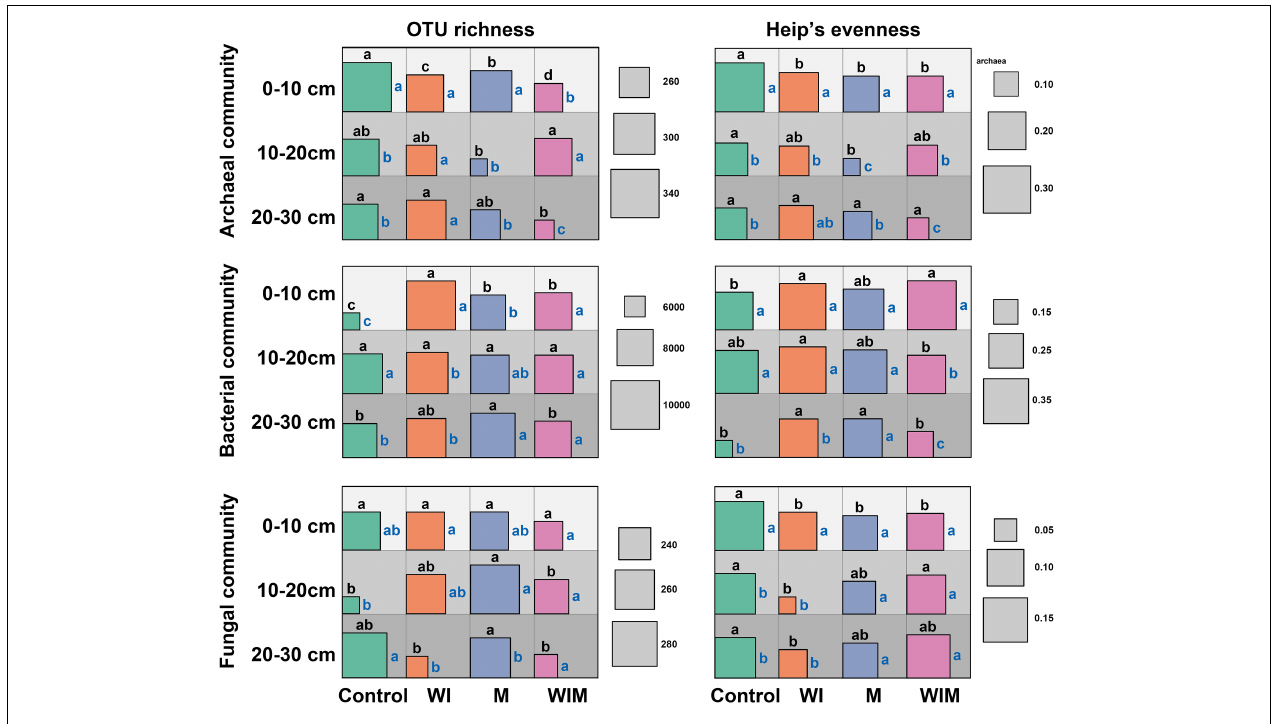
FIGURE 3 | Diversity (OTU richness and Heip’s evenness) of soil archaeal, bacterial and fungal communities. Different letters on the top of the square indicate significant differences among treatments within the same soil layer, and those on the right side indicate significant differences among layers within the same treatment. The significance of the difference was tested according to the Kruskal-Wallis rank sum test ( P > 0.05). WI, freezing saline water irrigation; M, plastic mulching; WIM, WI +